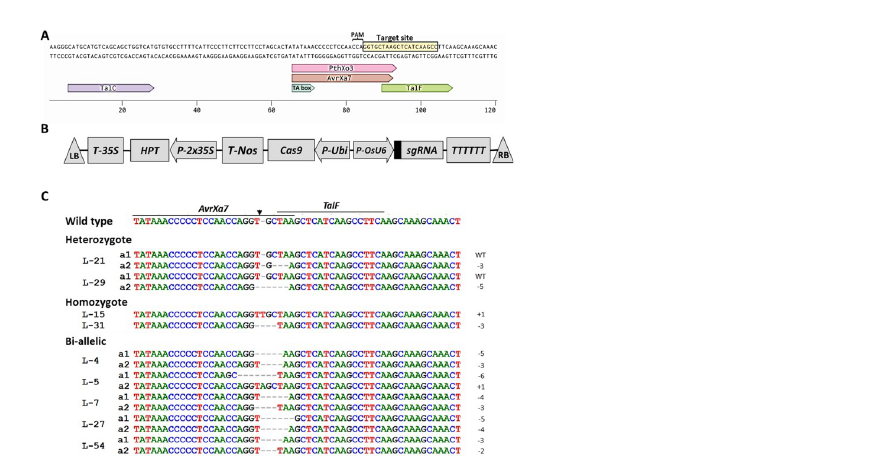
Fig 1. CRISPR/Cas9-induced OsSWEET14 promoter modification in TBR225 rice. (A) A region of the OsSWEET14 promoter containing four EBEs (TalC, PthXo3, AvrXa7 and TalF) and putative TATA box from TBR225. The target site (complementary to the guide RNA) is shown in the box, immediately following the protospacer adjacent motif (PAM). (B) T-DNA region of the CRISPR/Cas9-mediated genome editing construct carrying OsSWEET14-sgRNA (indicated by the black box). The expression of Cas9 is driven by the maize ubiquitin promoter (P-Ubi); the expression of the OsSWEET14-sgRNA is driven by the rice OsU6 promoter (P-OsU6a); the expression of HPT is driven by two CaMV35S promoters (P-2 × 35S); T-35S, T-Nos and TTTTTT: Gene terminators; LB and RB: Left and right border, respectively. (C) Alignment of the OsSWEET14 promoter fragment in the nine T 0 transgenic TBR225 rice plants edited in the AvrXa7, PthXo3 and TalF EBEs. The lines on top of the wild-type sequence represent the binding sites of AvrXa7, PthXo3 and TalF. The arrow indicates the expected cutting site of the Cas9 complex used in this study. The labels on the left indicate the name of examined mutant lines; (a1) and (a2) distinguish alleles in the same line. The numbers on the right indicate the type of mutation and the number of nucleotides involved; (+) and (-) indicate insertion and deletion,